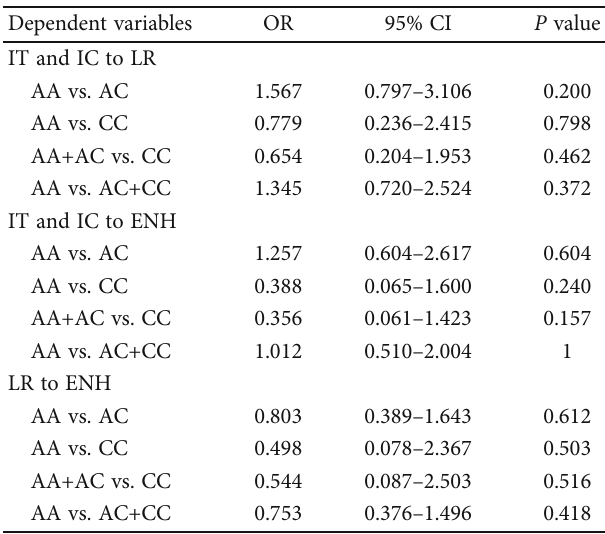
Table 3: The di ff erences of proportion between SNPs of IL10-592 A/C based on natural history of chronic hepatitis B